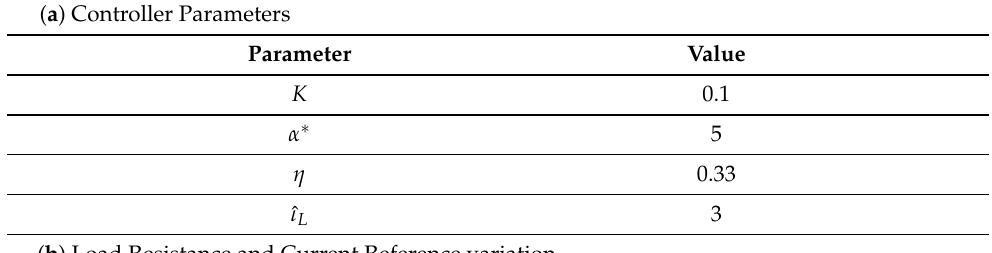
Table 3. Network parameters and load variation in buck mode. ( a ) Controller